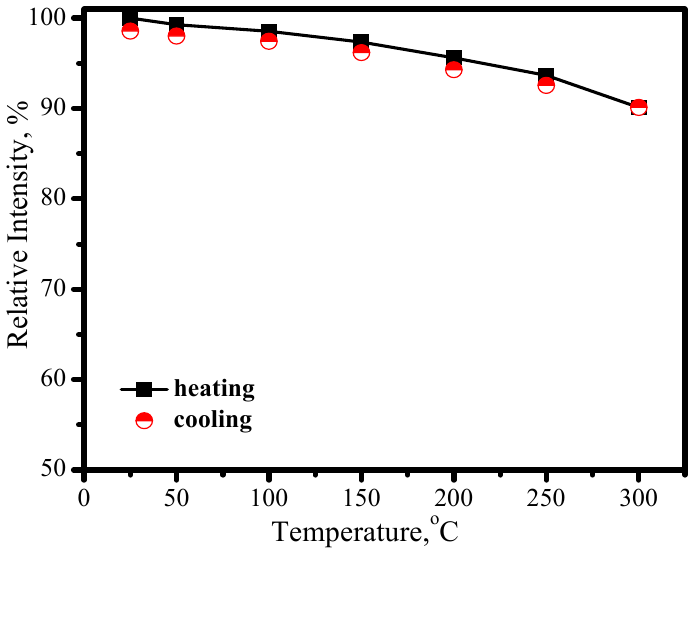
Ce ) Al O as a function of 0.9 0.01 3 5 13